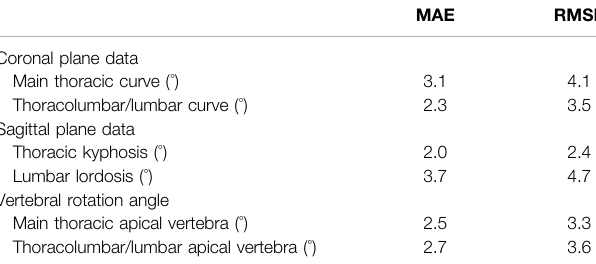
TABLE 4 | MAE and RMSE between CT images and simulation model.